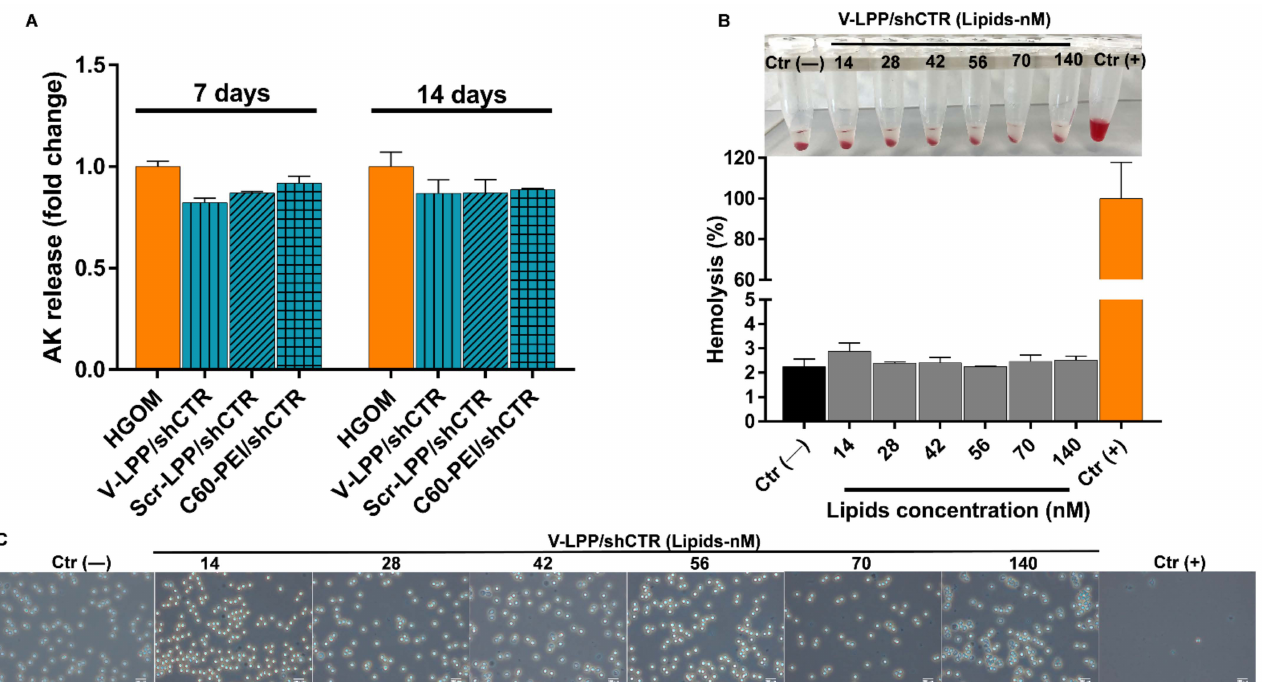
Figure 7. Cyto-/hemocompatibility evaluation of lipopolyplexes. ( A ) Cytotoxicity of V-LPP/shCTR lipopolyplexes measured as release of AK at 48 h after transfection performed on the 5th and 12th days. Data are presented as mean ± S.D. of one representative experiment done in three replicates. ( B ) Quantification of hemolysis in erythrocytes incubated with V-LPP/shCTR at different plasmid concentrations. The corresponding photographs of erythrocytes after their sedimentation are shown above the graph. ( C ) Evaluation of erythrocyte aggregation after incubation with lipopolyplexes by light microscopy. PBS [Ctr ( − )] and 0.5% Triton X-100 [Ctr (+)]. Scale bar: 200 µ m. Note that there are no significant changes in erythrocyte aggregation at any V-LPP/shCTR concentration